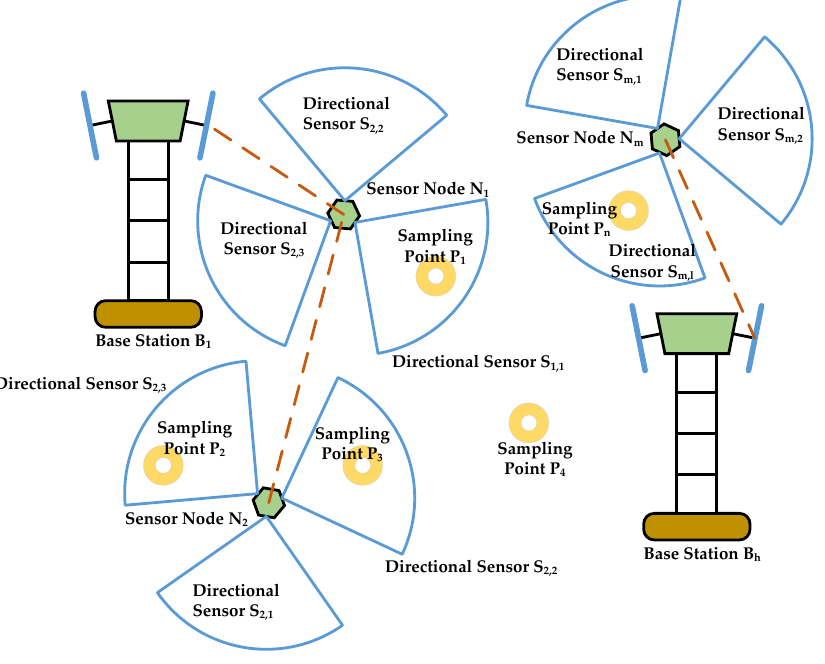
Figure 1. A coverage system model of Directional Sensor Networks